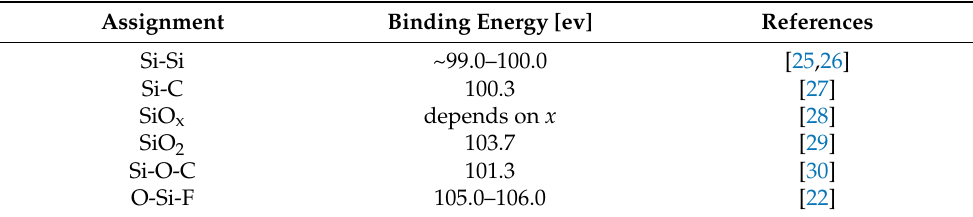
Table 1. Chemical groups and their respective energies in the Si 2p signal. The references are also